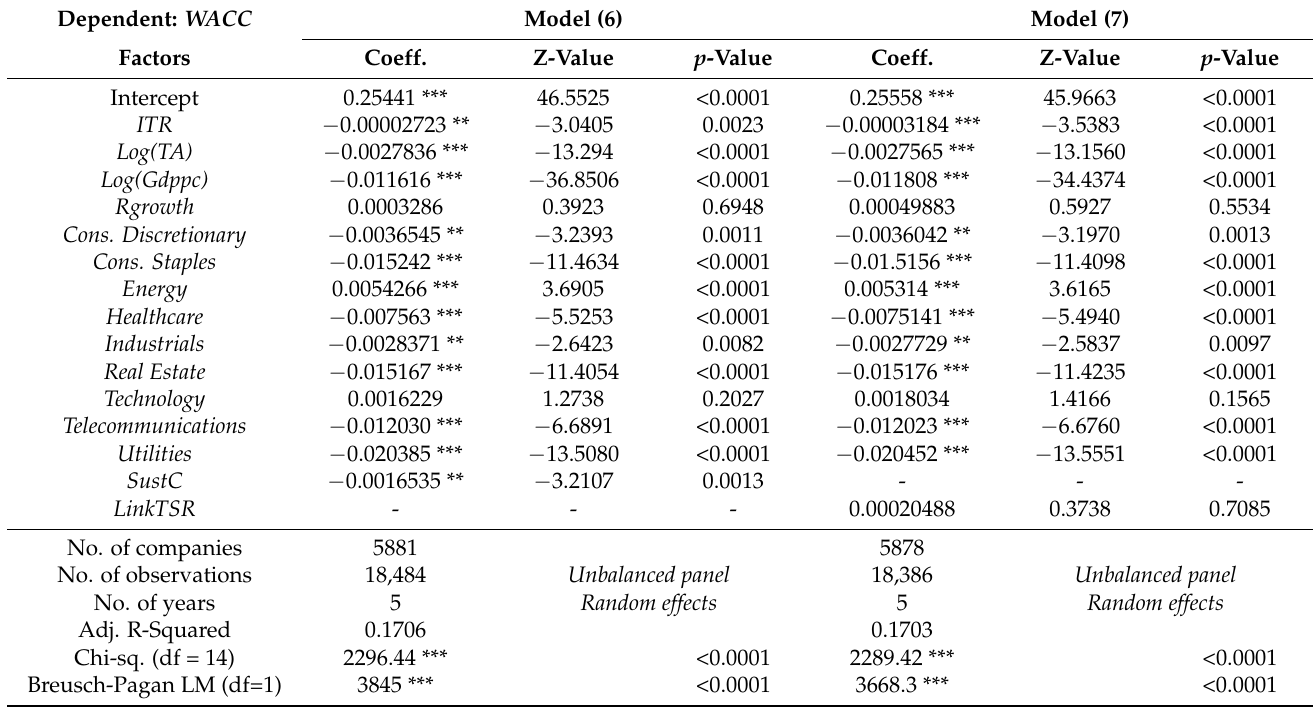
Table 10. Panel regression results for the weighted average cost of capital ( WACC) as the dependent variable in models (6) and (7).